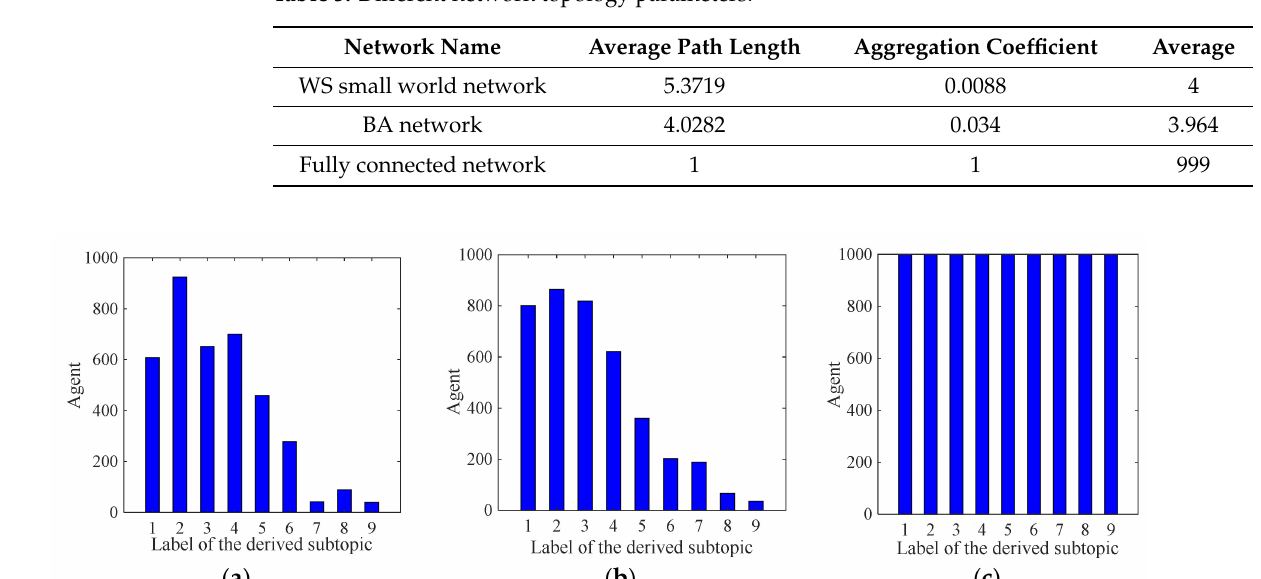
Table 3. Different network topology parameters.